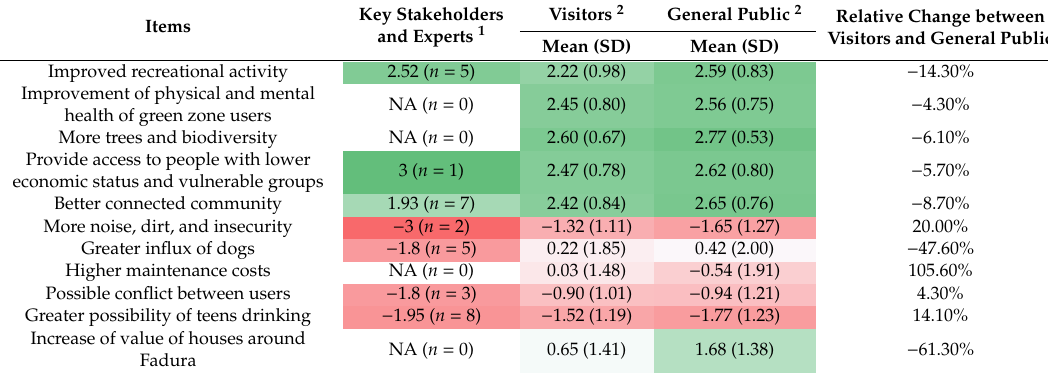
Table 3. Perceptions of the positive and negative impacts of implementing the Thinking Fadura project from the key stakeholders and experts of the workshop, visitors of the in-situ survey, and Getxo citizens of the general public survey. Figures indicate mean values in a Likert scale from − 10 to + 10 and relative change (%). Green and red colors indicate higher and lower values